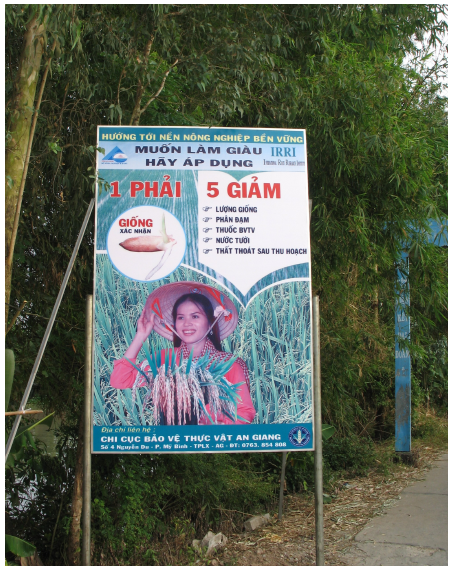
Figure 2. Billboard of 1 Must Do, 5 Reductions (Mot Phai, Nam Giam) along a road in a rice production area in An Giang province in the Mekong River